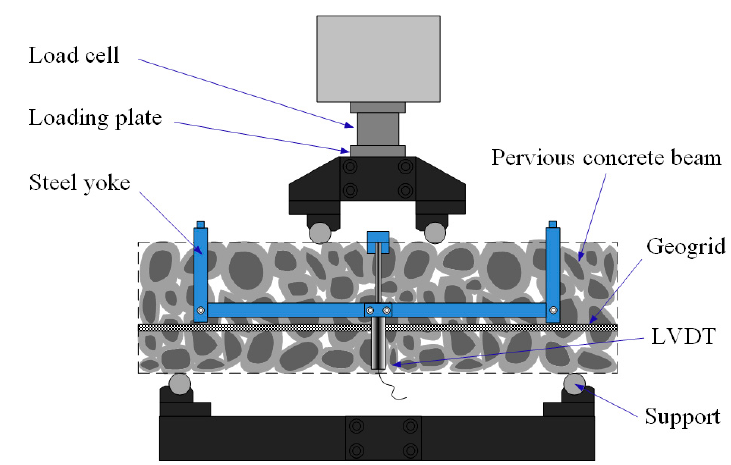
Figure 6. Four-point bending test setup.